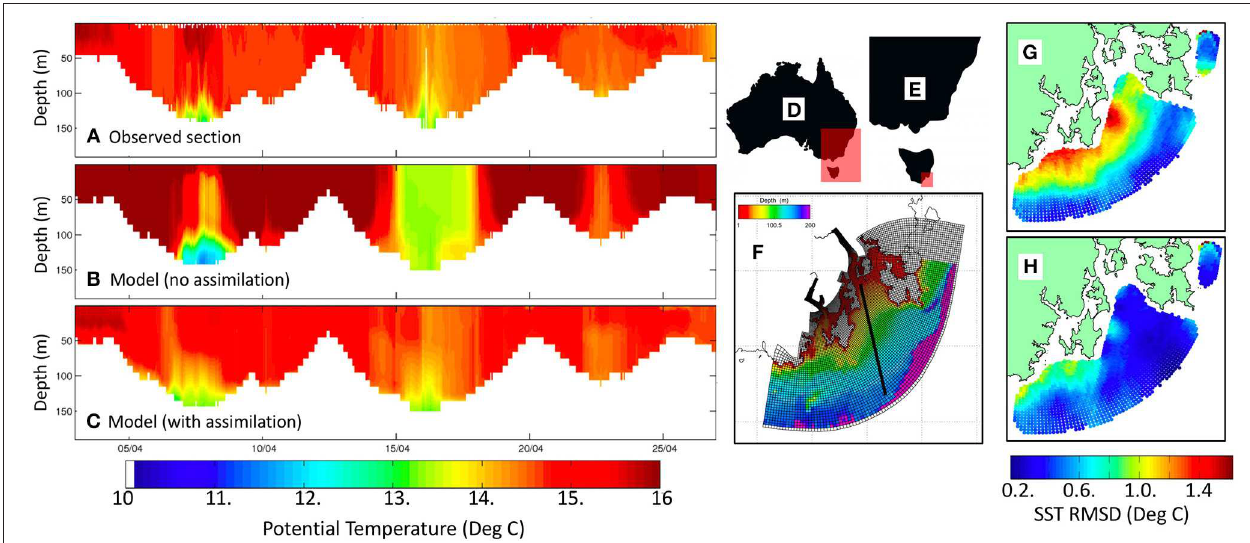
FIGURE 4 | Evaluation of gliders in the coastal sea south-eastern Tasmania using the Sparse Hydrodynamic Ocean Code and Ensemble OI (EnOI) data assimilation. Showing time series of potential temperature from (A) observations, and from the model with (B) no data assimilation (the control run) and (C) with data assimilation (the OSE run). The Model grid is shown in (F) , along with the model topography; with the grid location denoted by the red rectangles in (D,E) . A map of the RMS difference between the simulated and observed SST (G) without assimilation (the control run), and (H) with assimilation (the OSE run) are also shown. Adjusted from Jones et al.